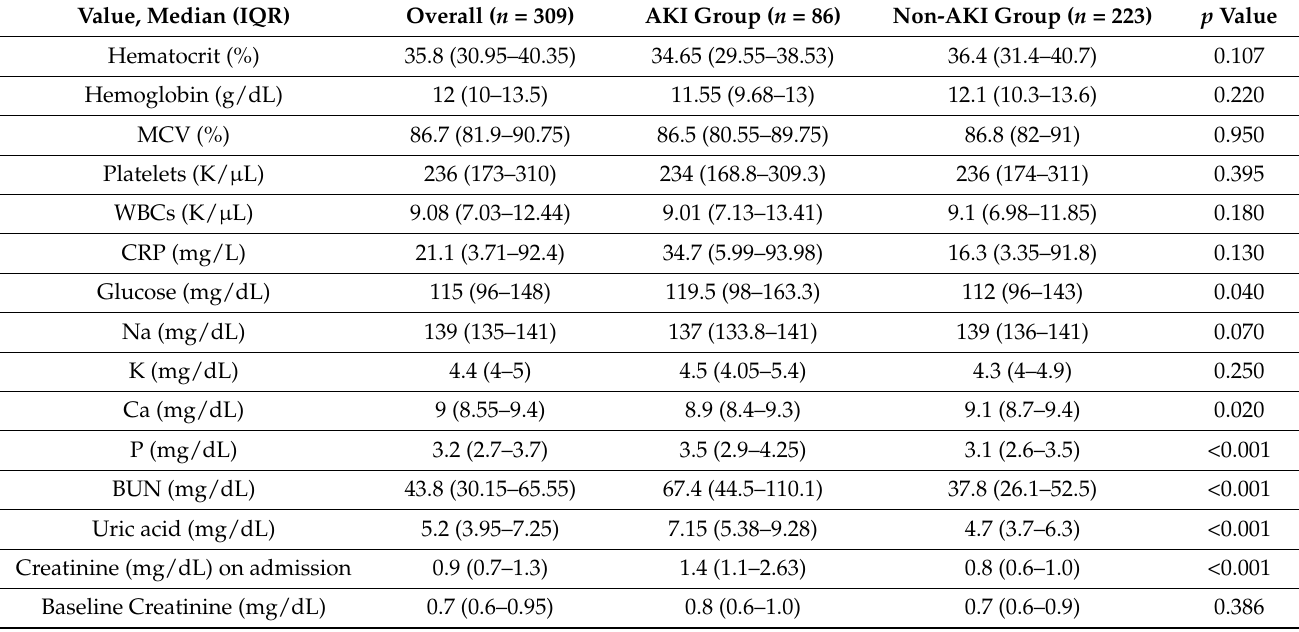
Table 3. Laboratory data of the emergency medical admissions according to the development of